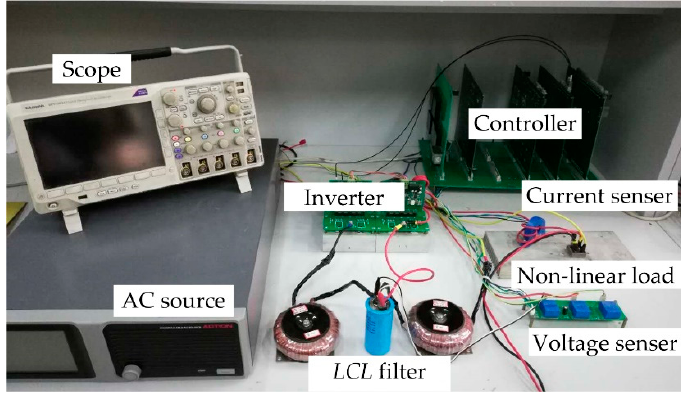
Figure 13. Experimental setup.